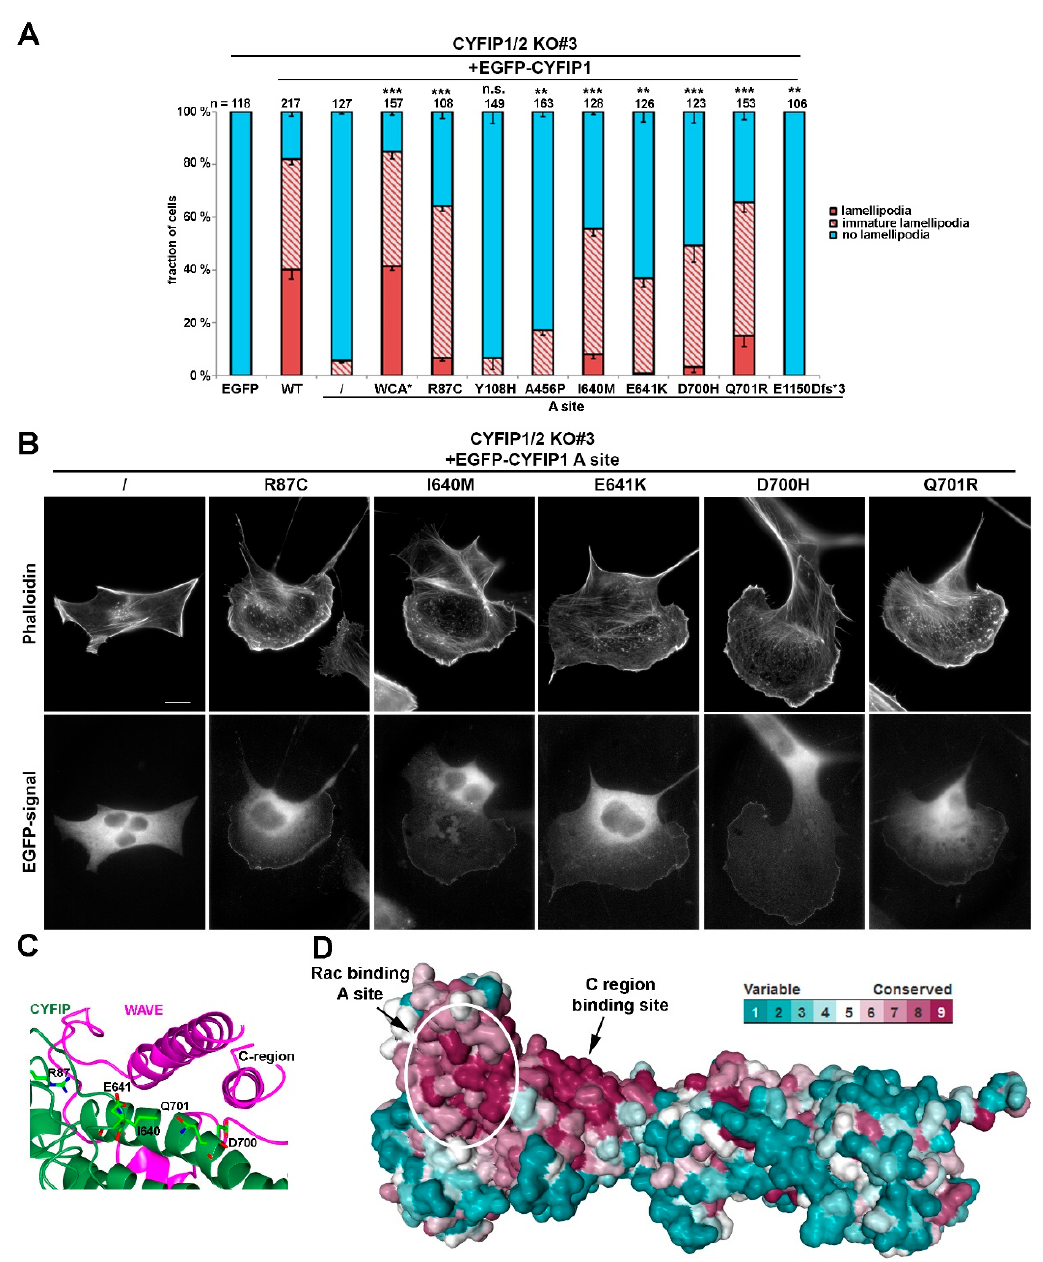
Figure 1. Intellectual disability-causing mutations in CYFIP frequently cause constitutive activation of WAVE regulatory complex (WRC). ( A ) Quantification of lamellipodia formation. Indicated, EGFP- tagged CYFIP1 constructs (or EGFP as control) were transfected into B16-F1 CYFIP1/2 KO cells (clone #3), and lamellipodia formation was assessed after staining of the actin cytoskeleton with ATTO 594- labelled phalloidin. Lamellipodial actin networks that were generally small, narrow, irregular, or displayed multiple ruffles were defined as ‘‘immature lamellipodia’’, as opposed to regular, fully developed lamellipodia [7]. n gives number of cells analyzed, and data correspond to arithmetic means ± SEM from at least three independent experiments. Statistical significance was assessed for differences between the percentages of cells with “no lamellipodia” phenotype. n.s.: not statistically significant; ** p < 0.01; *** p < 0.001 (two-sample, two-sided t-test). In all cases, statistical analysis was done for the A site mutant alone compared to each individual mutation introduced into the A site- mutated background. ( B ) Cell morphologies of CYFIP1/2 KO cells (clone #3) expressing respective constructs, as indicated. Panels in top row show stainings of the actin cytoskeleton with phalloidin, and bottom row images show fluorescence of the same cells derived from EGFP fluorescence. Scale bar, 10 µm. ( C ) Close up view of the interface between CYFIP and the C-region of WAVE, required for transinhibition of WAVE’s WCA domain. Mutations in CYFIP presumably causing constitutive